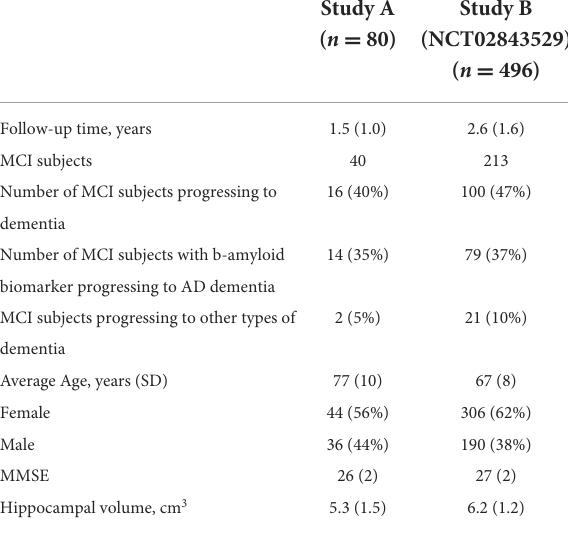
TABLE 1 Demographic characteristics of the full sample longitudinal dataset.